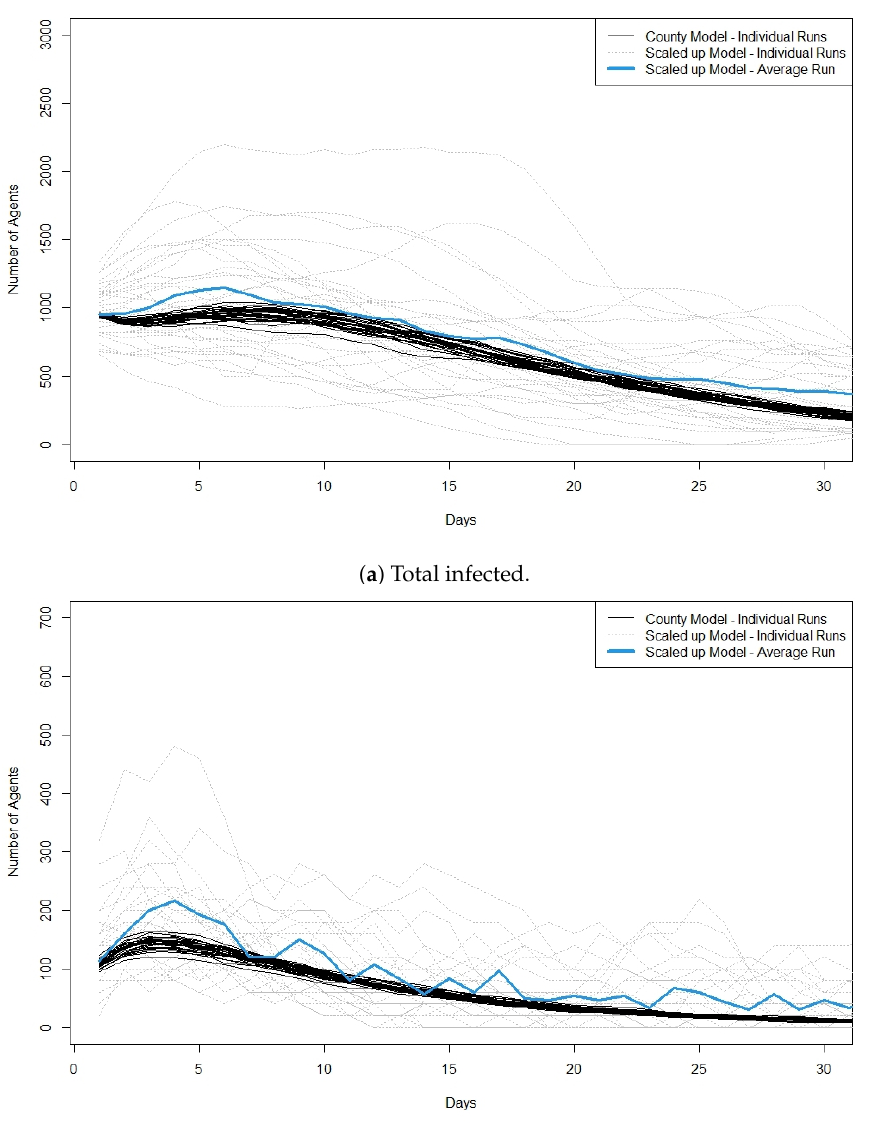
Figure 2. Plots showing cross validation results when 1000 agents are infected at the start of the run in the original model and 10 agents are infected at the start of the run in the scaled model. ( a ) shows the total number of infected agents per day and ( b ) shows the newly infectious agents per day. For the scaled model the y -axis is the number of infected × 100. We also plot the average value across the 30 runs of the scaled model. Best viewed in